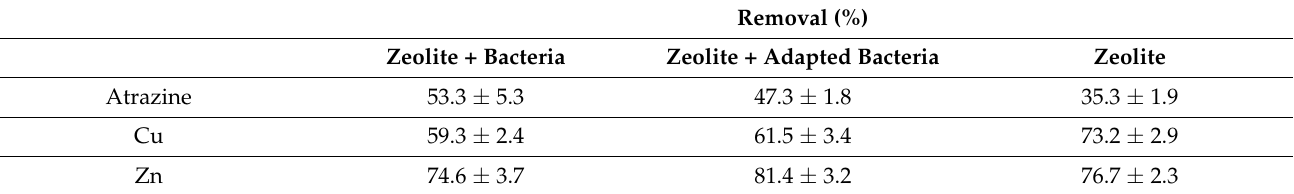
Table 1. Removal percentages of atrazine (1 mg/L), Cu and Zn (40 mg/L) for the different experiments